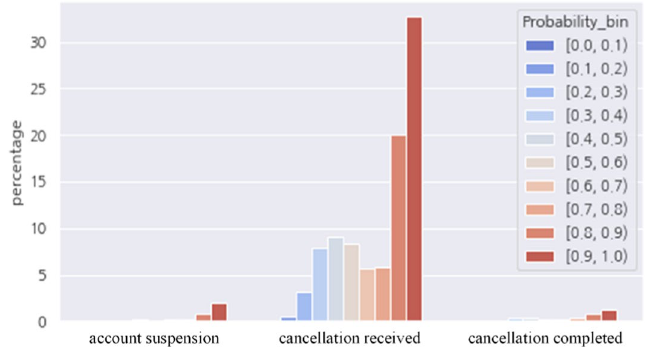
Fig. 15 Proportion of number of customers by prediction probability according to contract